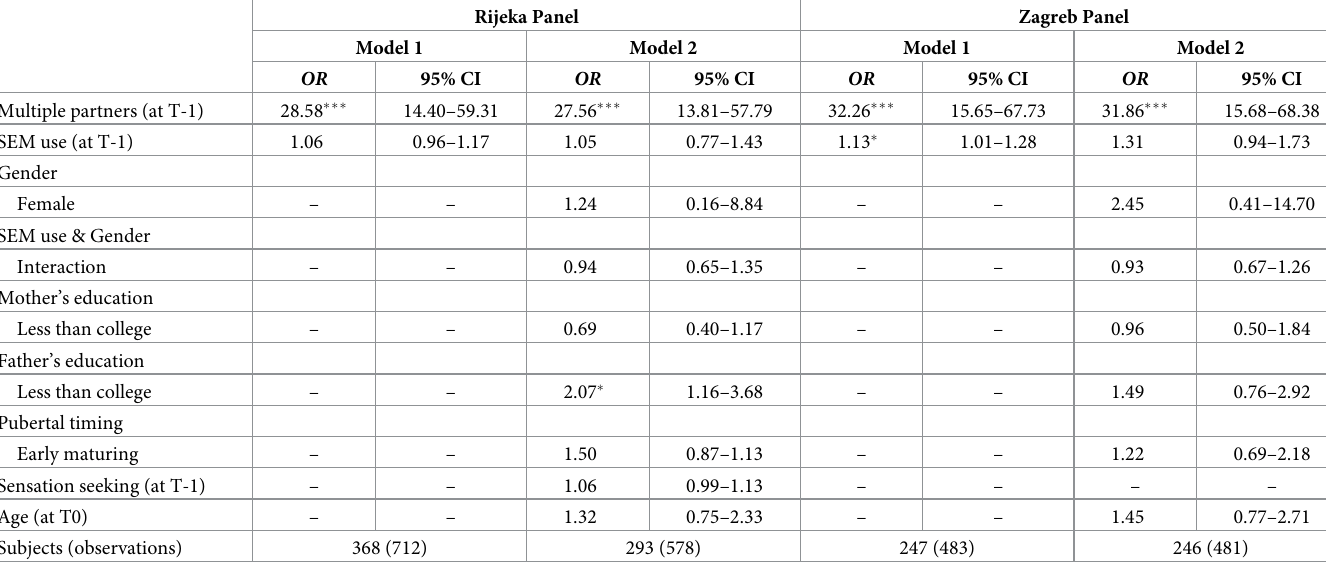
Table 4. Multivariate assessment of associations between the frequency of SEM use and reporting two or more sexual partners in the Rijeka and Zagreb